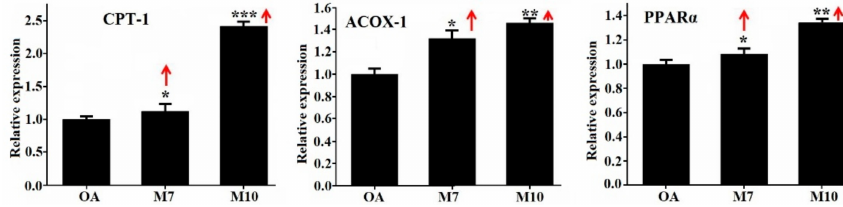
Figure 6. E ff ects of VIAPW (M7) and IRWWW (M10) from miiuy croaker ( M. miiuy ) muscle on the expression levels of genes involved in lipid synthesis (SREBP-1c, SREBP-2, FAS, ACC, and HMGR) and oxidation (PPAR α , ACOX-1, and CPT-1) in HepG2 cells. Means ± SD (n = 3) are used to express the experiment data. *** p < 0.001, ** p < 0.01, * p < 0.05 versus OA model